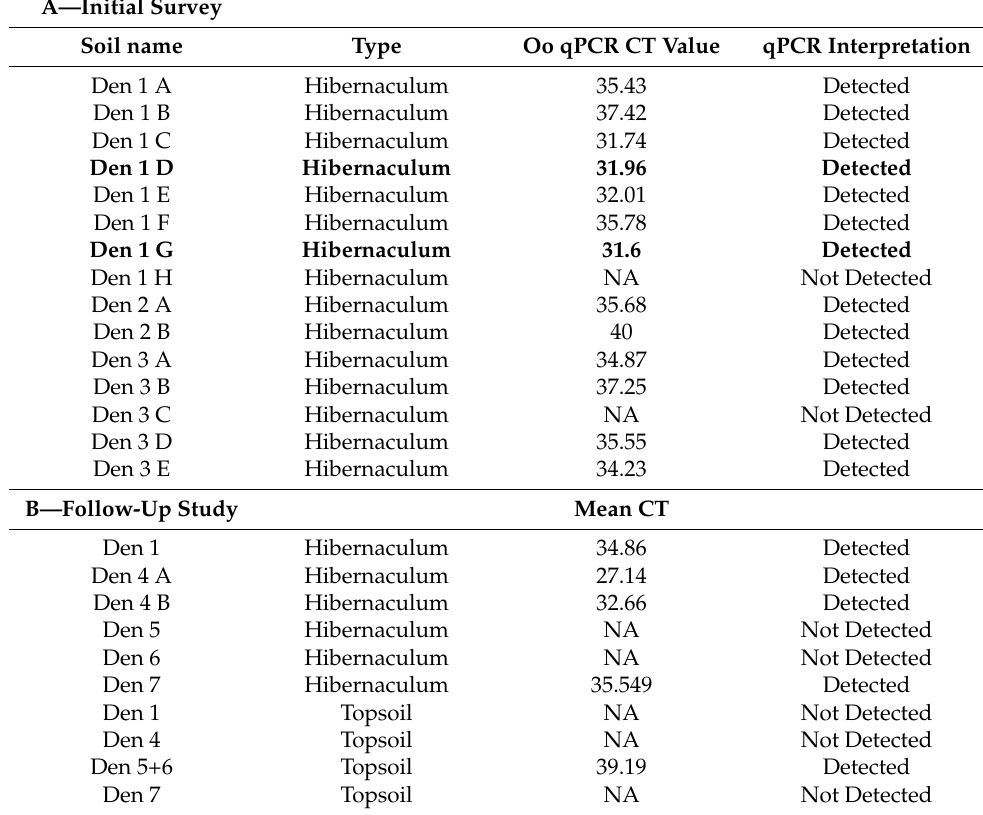
Table 1. Detection of Ophidiomyces ophidiicola (Oo) in soil samples. The amount of Oo in each soil was assessed using qPCR. (A) Results of initial survey. Soils reported in bold text are those which produced viable Oo colonies when cultured. (B) Results of follow-up study which included sampling soil within snake dens/hibernaculum and adjacent topsoil samples. Den 4 is represented by two hibernaculum soil samples due to the presence of two distinct hibernation chambers and dens 5 and 6 are represented by a single topsoil sample due to their proximity. The amount of Oo in each sample was assessed using three replicate extractions, each quantified using a single qPCR. The cycle threshold (CT) values presented here represent the mean CT value for that soil sample. NA = no amplification of target